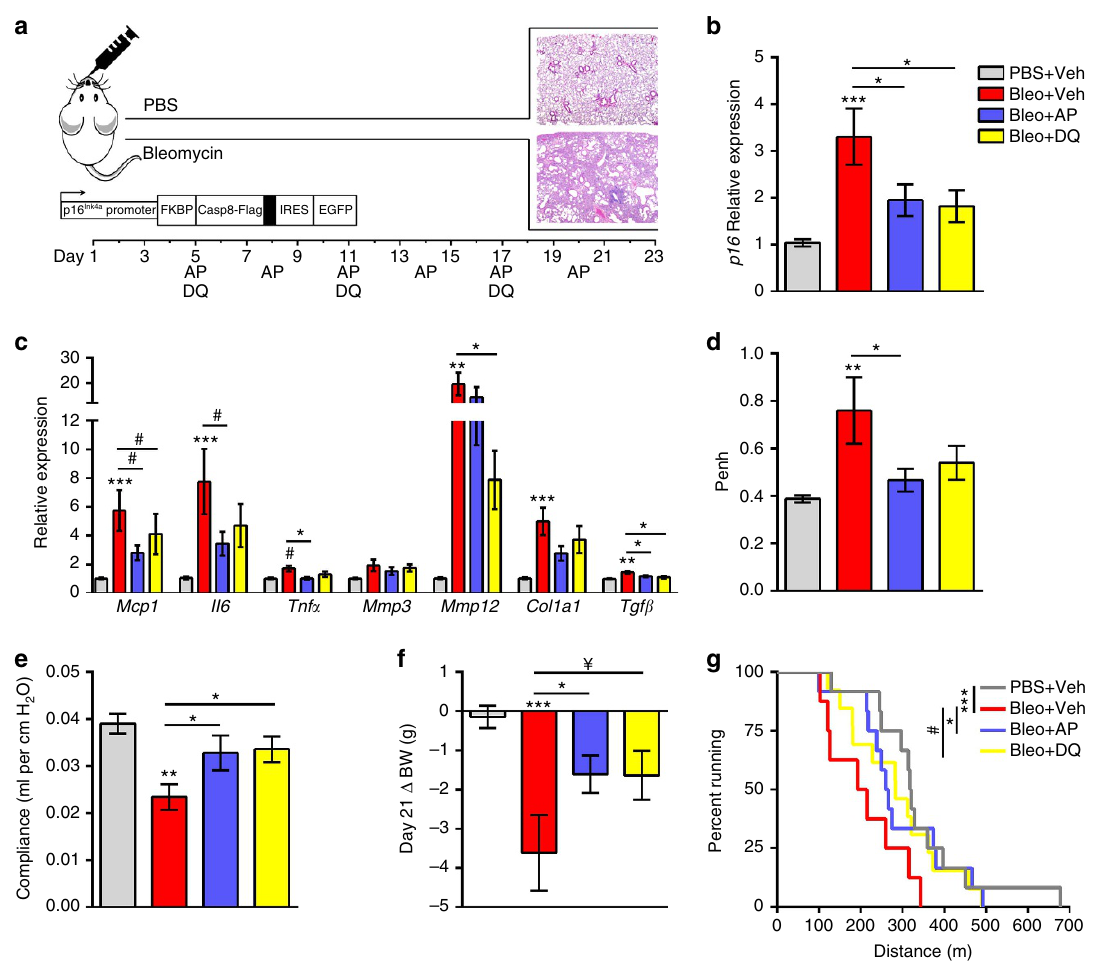
Figure 4 | Senescent cell clearance improves pulmonary and physical health in bleomycin injury. ( a ) Ink-Attac transgenic mice receiving bleomycin (Bleo) through aerosolized intratracheal instillation were randomized to receive vehicle (Veh), AP or DQ and compared with PBS-exposed mice treated with Veh. Treatment timeline is indicated. Mice were killed 3 weeks post challenge, a time point at which lung fibrosis peaks 15 (haematoxylin and eosin (H&E) panels top: PBS, bottom: Bleo). Lung expression of ( b ) p16 , ( c ) SASP factors Mcp1 , Il6 , Tnf a , Mmp3 , Mmp12 and profibrotic factors Col1a1 and Tgf b were quantified by RT–PCR and are expressed relative to Hprt levels. ( d ) Whole-body plethysmography was used to assess enhanced pause (Penh), an indirect measure of airway resistance. ( e ) Lung compliance was ascertained by FlexiVent forced oscillation technique at endpoint. ( f ) Twenty-one-day body weight (BW) was compared with baseline body weight. ( g ) Exercise capacity was assessed through a treadmill test; distances ran to exhaustion are depicted (mean ± s.e.m.; PBS þ Veh n ¼ 13 (grey), Bleo þ Veh n ¼ 8 (red), Bleo þ AP n ¼ 12 (blue), Bleo þ DQ n ¼ 13 (yellow); linear regression